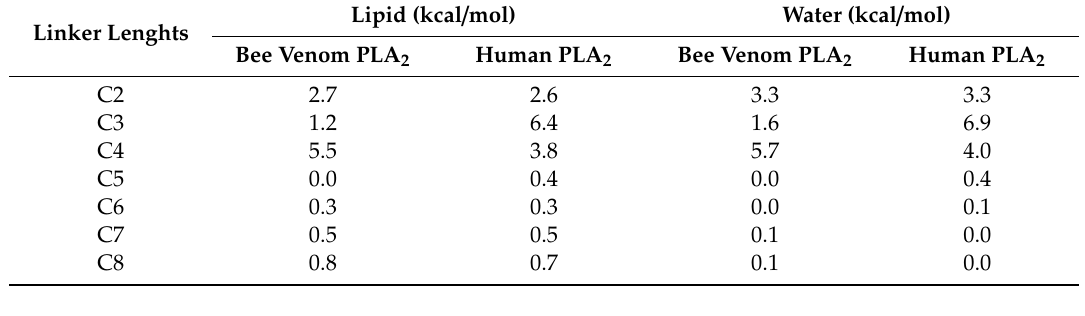
Table 1. Binding free energies of PL-methotrexate prodrugs in bee venom vs. human PLA 2 transition state from water or lipid (kcal / mol), as calculated by the thermodynamic cycle illustrated in Figure 2. All simulations had standard error of the mean (SE) in the range of 0.5–1.0 kcal / mol.